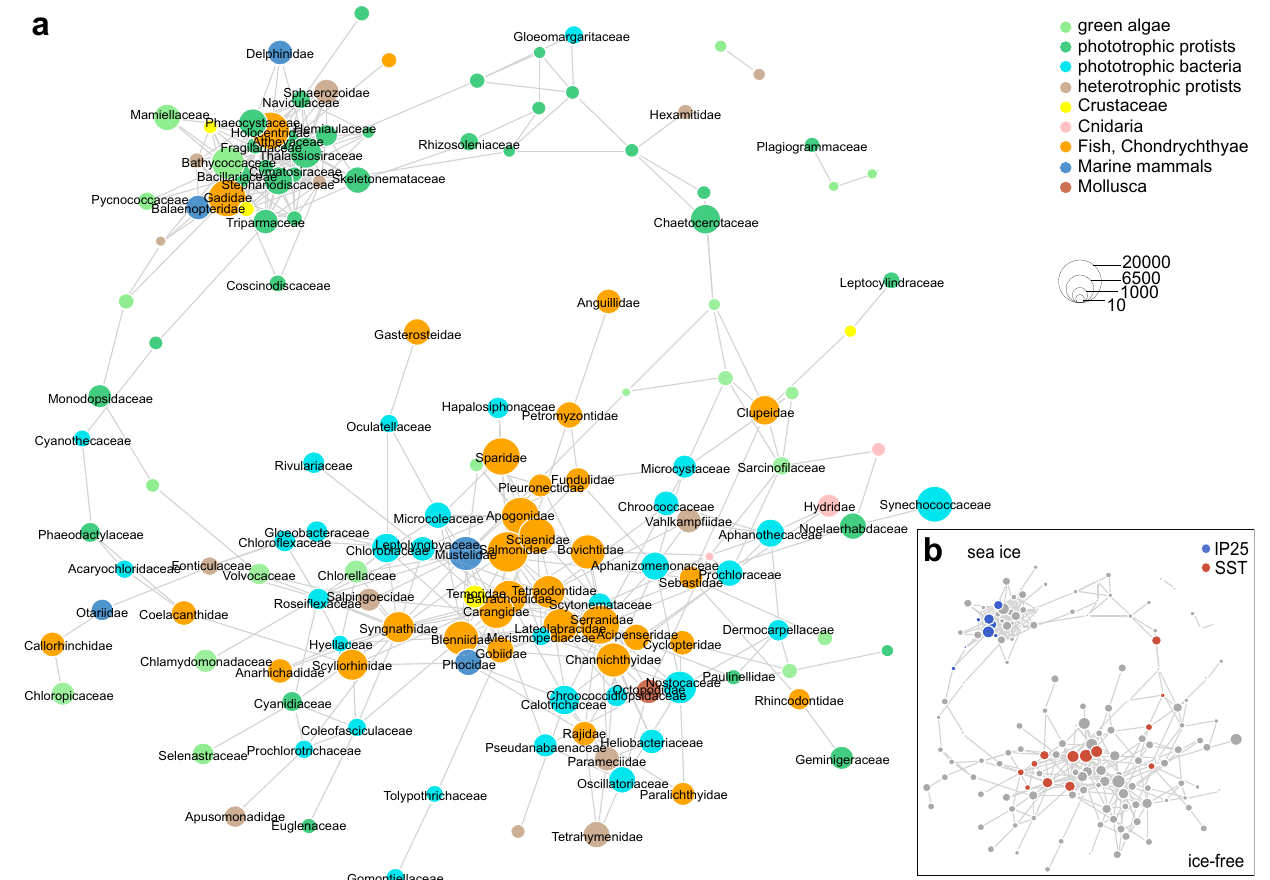
Fig. 3 | Correlation network of pelagic families. Families (nodes) that are posi- tivelycorrelated(Spearmanrankcorrelationcoef fi cients>0.4,Benjamini – Hochberg adjusted p value < 0.1) with each other are connected by links (edges) after resam- pling. The node size is log-scaled according to taxa abundance, while node colors represent a the functionalgroup to which the organisms belong, and b whether the